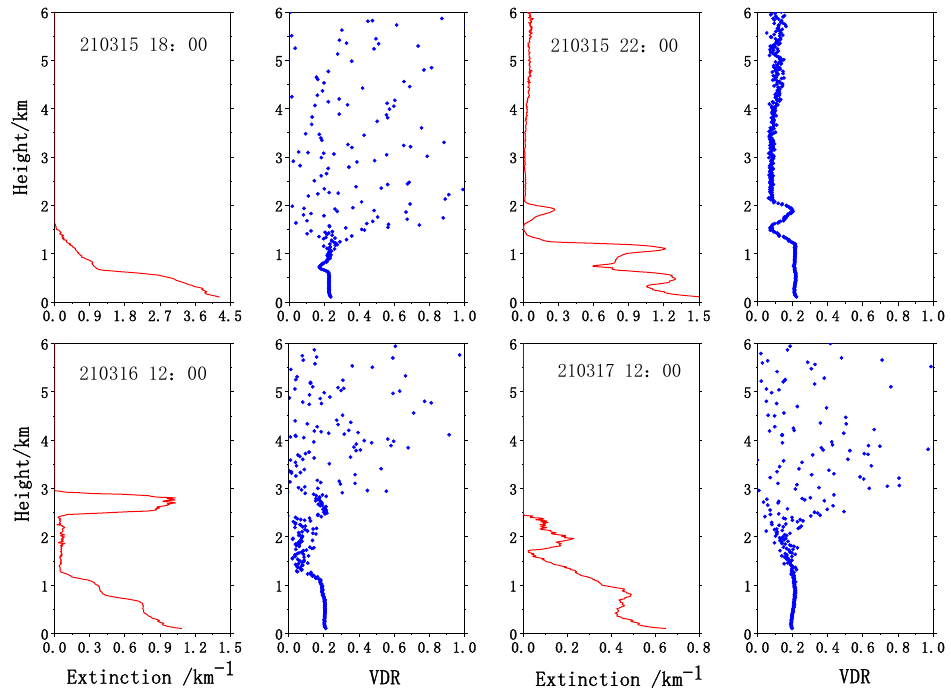
Figure 4. Vertical profiles of the extinction coefficient (read lines) and the VDR (blue lines) at several typical moments.